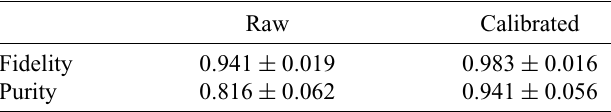
TABLE II. Average fidelities and purities of the reconstructed input states for d = 5 with the corresponding standard